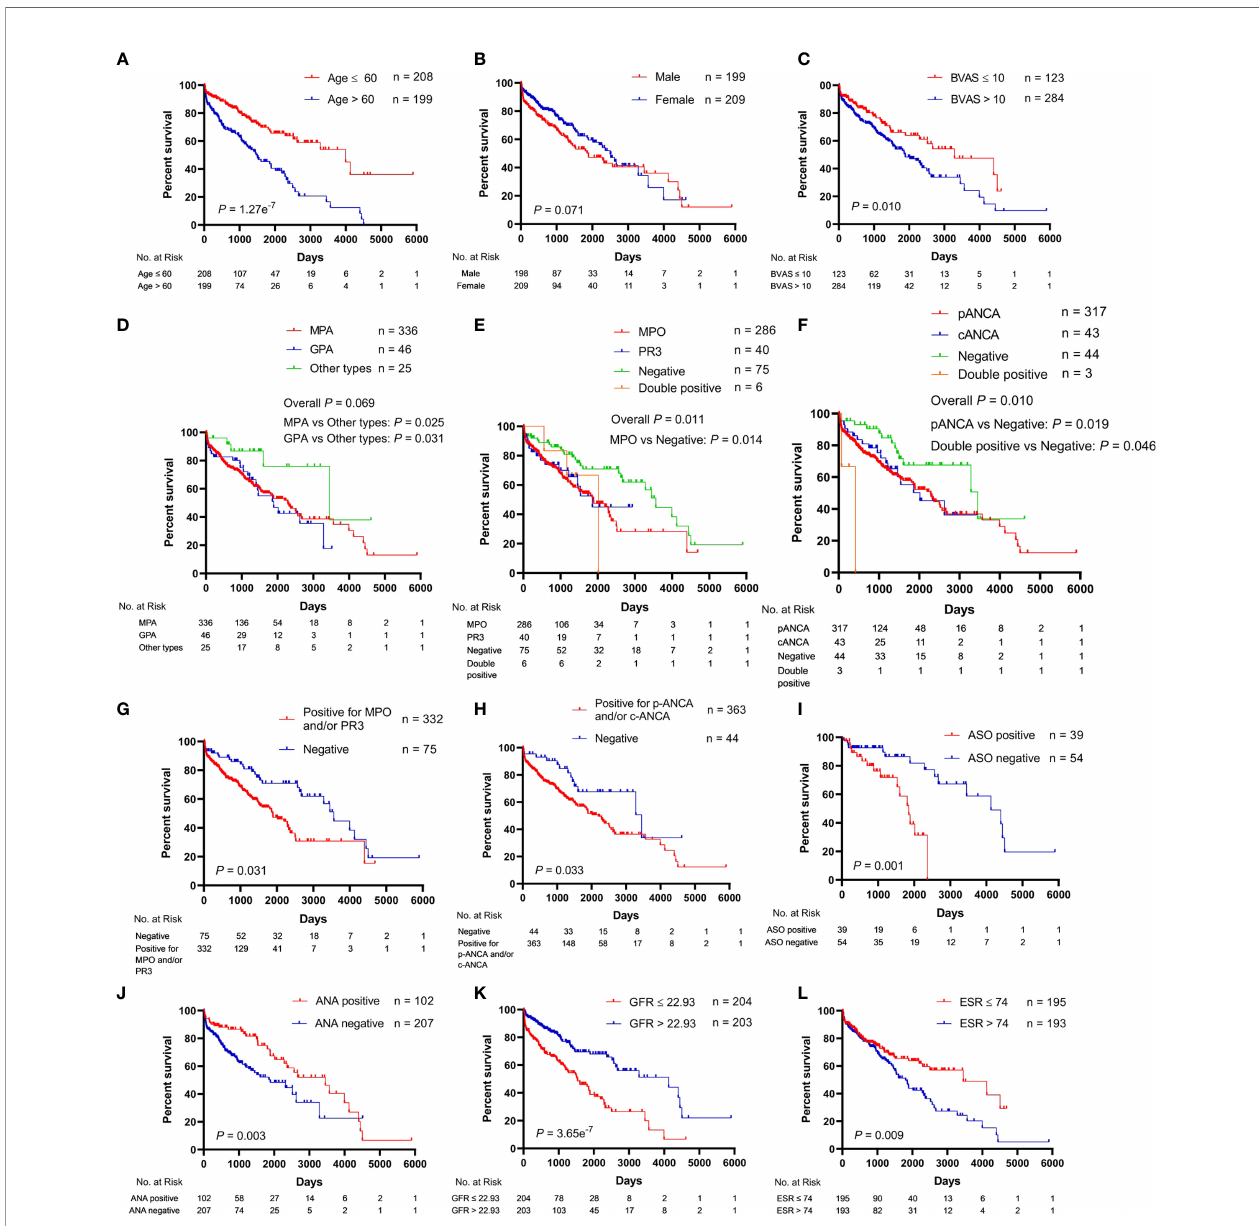
FIGURE 1 | Association of clinicalcharacteristics with overallsurvival inpatients with antineutrophilcytoplasmicantibody (ANCA)-associated vasculitis. (A) Age. (B) Gender. (C) BVAS, Birmingham vasculitis activity score. (D) Pathological categories (MPA, GPA, and other types). MPA, microscopic polyangiitis; GPA, granulomatosis with polyangiitis. (E) Serum ANCA types (MPO,PR3, negative, and doublepositive for MPO and PR3) classi fi ed by the ELISA. MPO, myeloperoxidase; PR3, proteinase 3. (F) Serum ANCA types (p-ANCA, c-ANCA, negative, and doublepositive for p-ANCA and c-ANCA) classi fi edby the indirect immuno fl uorescence (IIF) assay.p-ANCA, perinuclear ANCA; c-ANCA, cytoplasmicANCA. (G) Negative vs. positive for MPO and/or PR3. (H) Negative vs. positive for p-ANCA and/or c-ANCA. (I) ASO, anti- streptolysin O. (J) ANA, antinuclear antibody. (K) GFR, glomerular fi ltration rate. (L) ESR, erythrocyte sedimentation